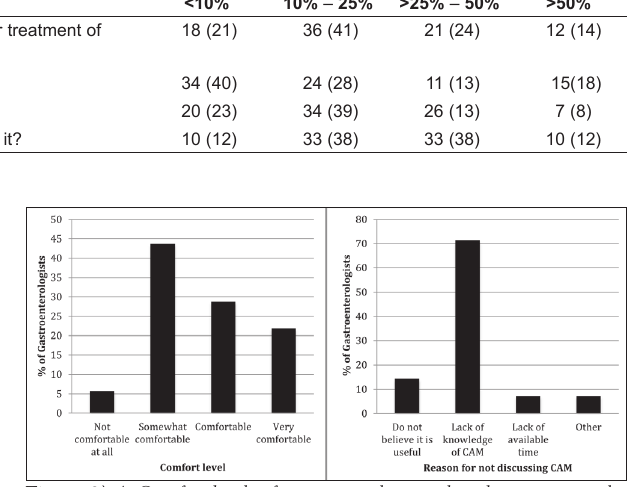
Figure 2) A Comfort levels of gastroenterologists when discussing comple- mentary alternative medicine (CAM) with their patients. B Reason that